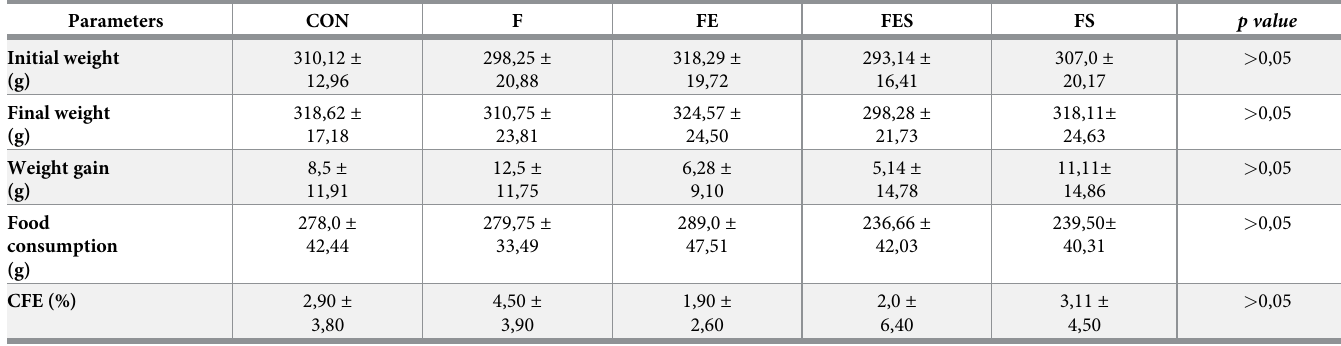
FEC: food efficacy coefficient; CON, control; F, fibromyalgia induced; FE, fibromyalgia induced plus exercise; FES, fibromyalgia induced plus exercise and